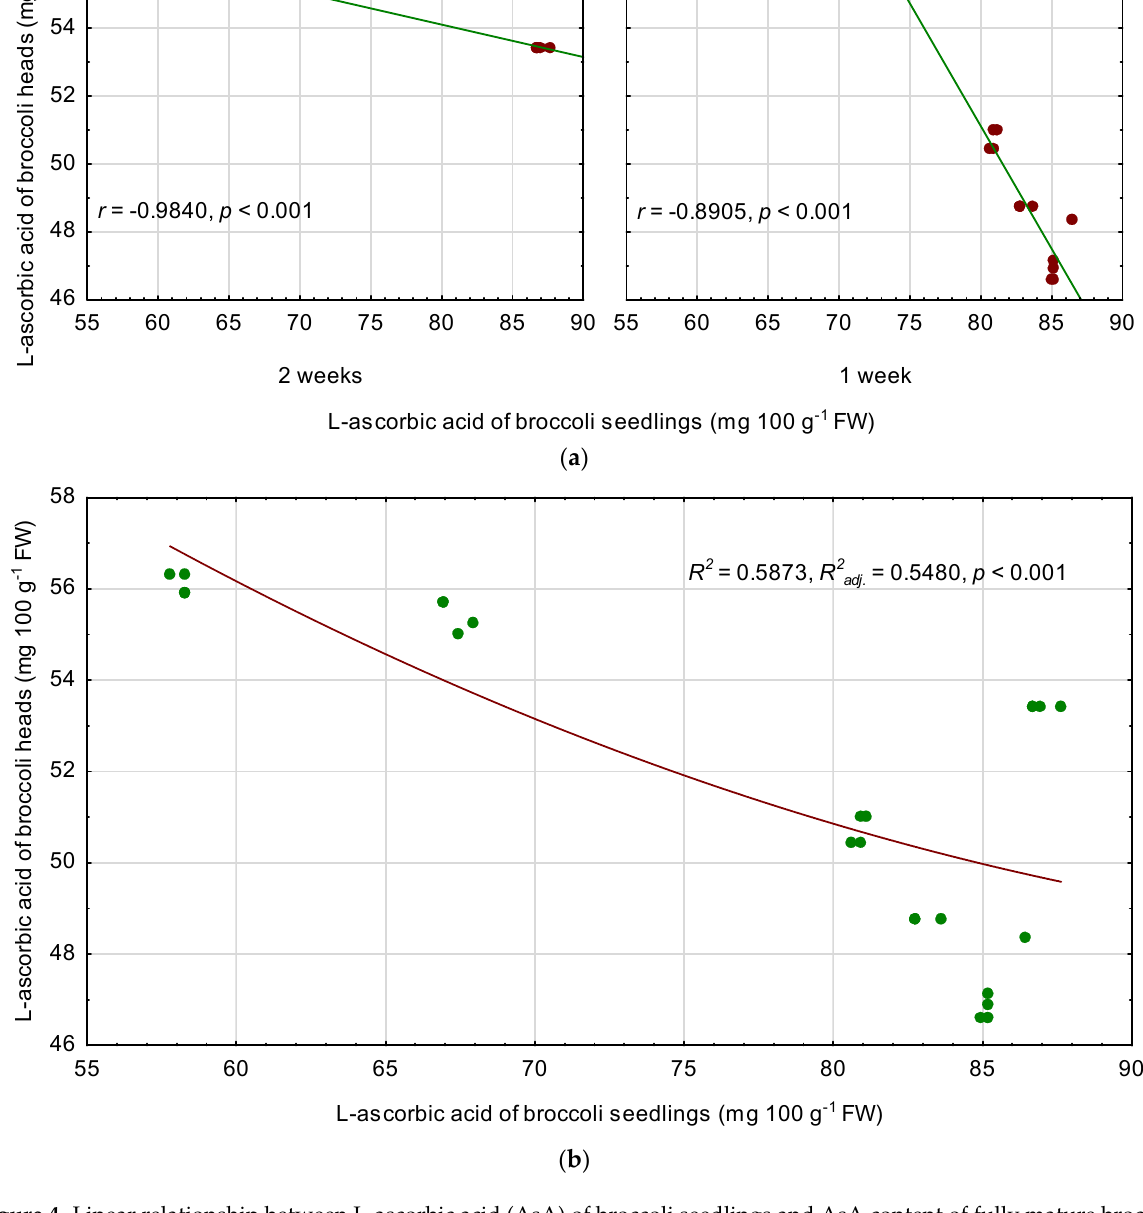
Figure 4. Linear relationship between L-ascorbic acid (AsA) of broccoli seedlings and AsA content of fully mature broccoli heads, separately for temperature duration ( a ), and polynomial regression model for AsA content of broccoli heads depending on the AsA content of the seedlings ( b ). r —Pearson correlation coefficient, R 2 —coefficient of determination, R 2adj. —adjusted coefficient of determination, p —probability level.